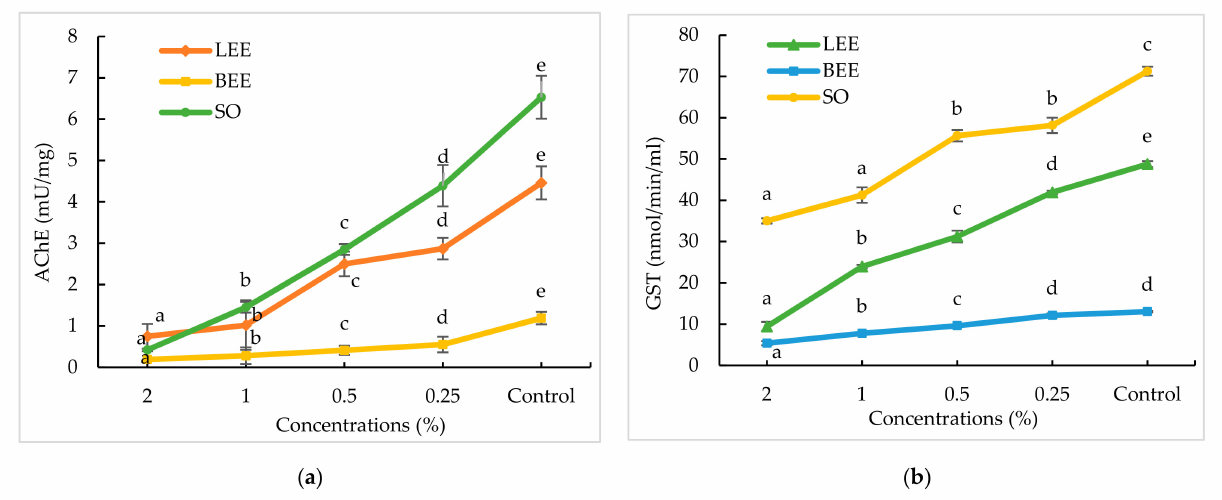
Figure 1. Detoxification enzyme activities: AChE ( a ) and GST inhibition ( b ) in Aphis craccivora treated with leaf ethanolic extract (LEE), bark ethanolic extract (BEE), and seed oil (SO) of Triadica sebifera . Bars represent standard error ( ± SE) of three replications. Means followed by the same letters within a column do not differ significantly by Tukey’s HSD test ( p ≥